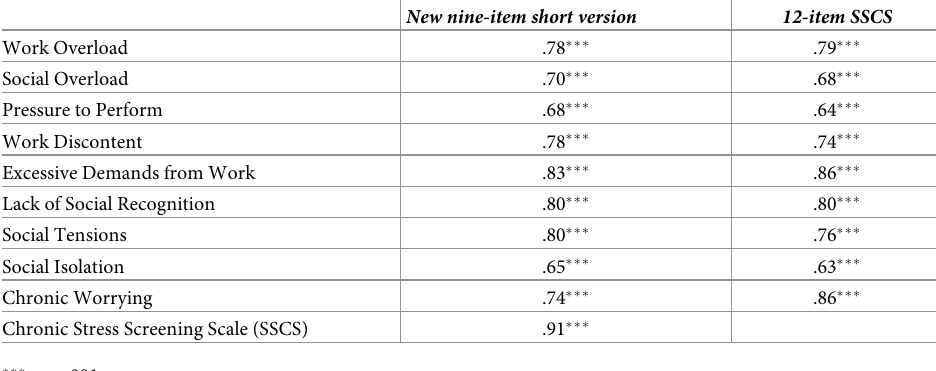
Table 3. Correlation coefficients (Pearson) of the new nine-item short version of the TICS, the 12-item short screening scale of the TICS and the scales of the 57-item long version of the TICS (N =